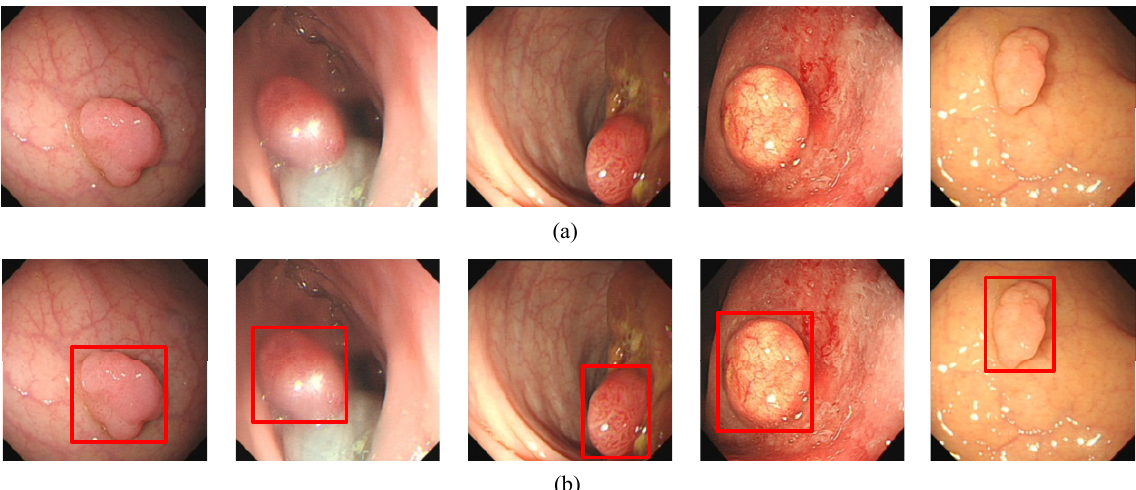
Figure 2. The polyp object detection WCY dataset: ( a ) Polyp image samples, ( b ) ground-truths with bounding boxes. The red squares in the figure are the bounding boxes of the polyps.